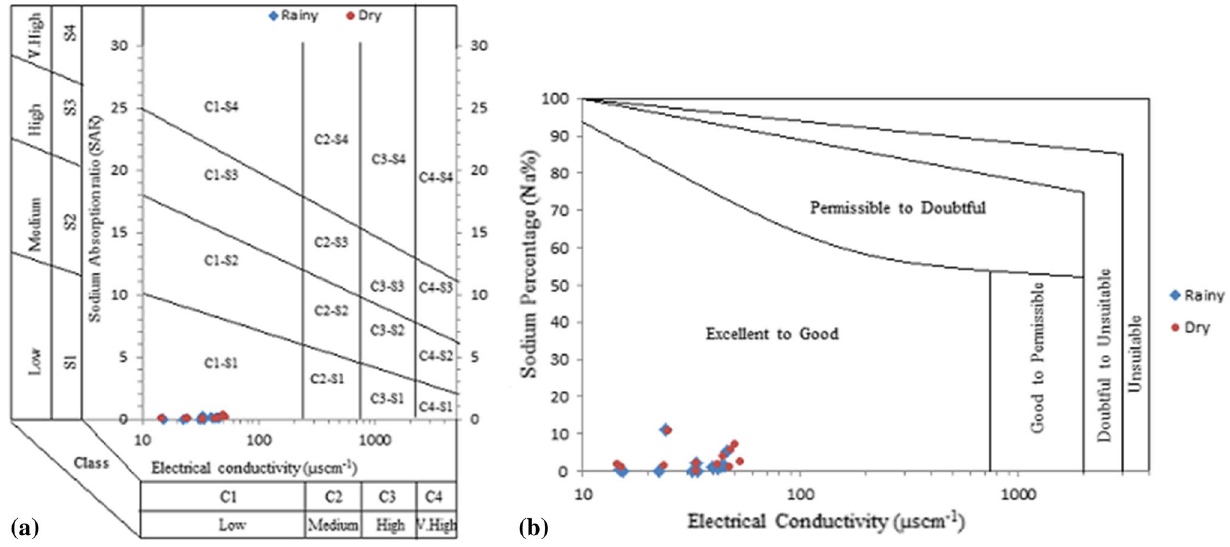
Fig. 10 River Mamu basin’s irrigation water